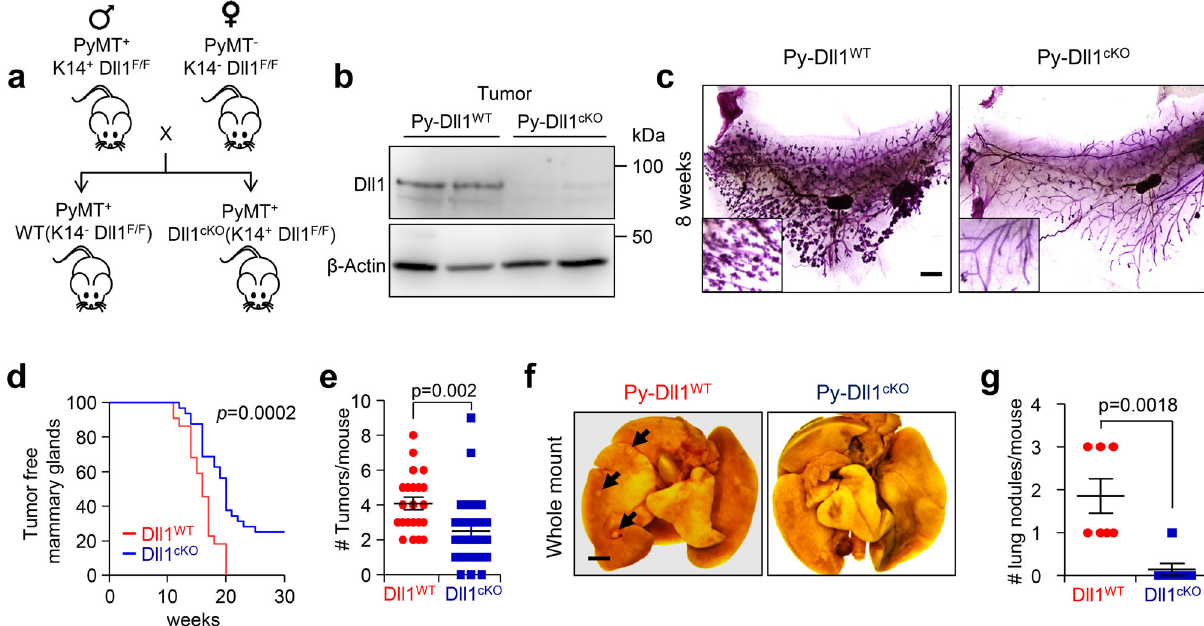
Fig. 1 Conditional knockout of Dll1 signi fi cantly delays tumor initiation and lung metastasis in MMTV-PyMT model. a Schematic shows the strategy to generate MMTV-PyMT; Dll1 cKO mice. b Western blot shows reduced Dll1 protein in PyMT-Dll1 cKO tumor cells compared to PyMT-Dll1 WT tumor cells. c The representative whole mount alum carmine-stained images show the hyperplasia stages of MMTV-PyMT in indicated Dll1 genotypes. Insets show a zoomed-in image to a difference in branching. n = 5 PyMT-Dll1 WT , n = 6 PyMT-Dll1 cKO hyperplastic mammary glands at the age of 8 weeks. d Kinetics of mammary tumor onset in MMTV-PyMT females of indicated genotypes as shown by Kaplan – Meier plot. PyMT-Dll1 WT ( n = 22 mice) and PyMT-Dll1 cKO ( n = 32 mice) were used. e Scatter plot shows the number of spontaneous tumors in PyMT-Dll1 WT ( n = 22 mice) and PyMT-Dll1 cKO ( n = 32 mice). The mammary gland was considered tumor-positive when the tumor was 3 × 3 mm in dimension. f The representative whole mount images show metastatic lung nodules (black arrows) in PyMT-Dll1 WT , which is absent in the PyMT-Dll1 cKO mice. The lung nodules were quanti fi ed under dissection microscope after 24-h fi xation with bouin ’ s solution (please see method section for details). g The scatter plot shows the number of lung nodules in spontaneous tumors bearing PyMT-Dll1 WT and PyMT-Dll1 cKO mice ( n = 7 mice per group). two-tailed Log-Rank test d and two-tailed unpaired Student ’ s t- test e, g were used to calculate p values. Data present two b or three c or seven f independent experiments. e , g Data are presented as the mean ± SEM. Scale bars, 500 µ m c and 400 µ m f . Source data are provided as a source data fi